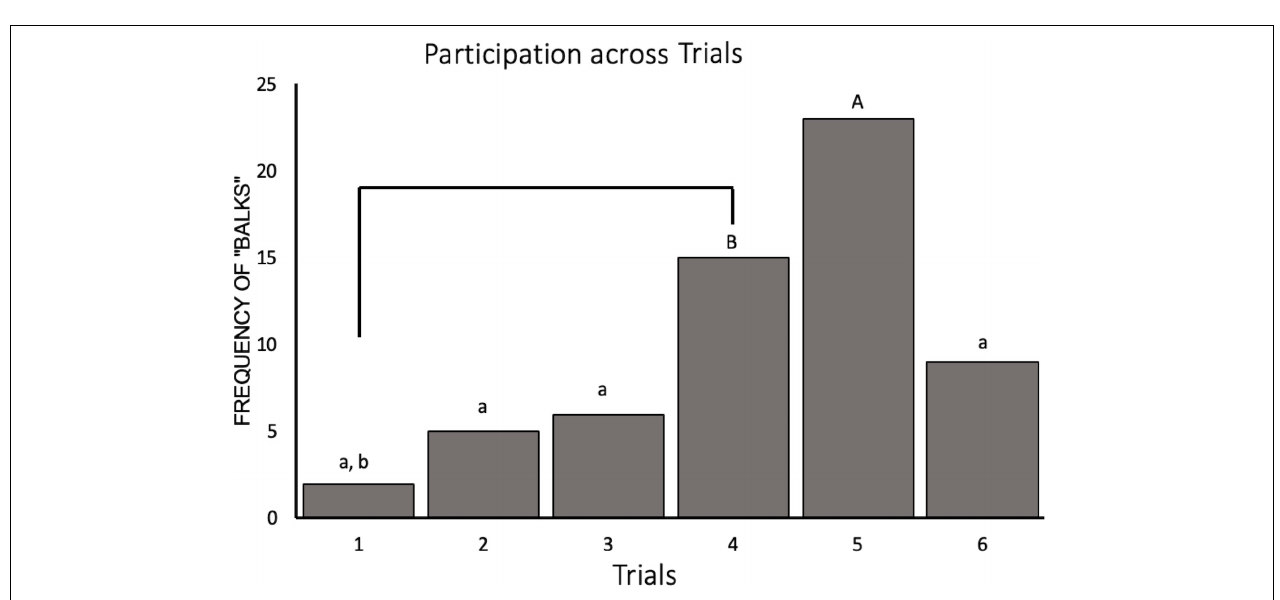
FIGURE 2 | A summary of each infant behavior ( N = 25) by condition. Locomotion represents the number of times an infant crossed a gridline, vocalizations are a count of all infant vocalizations during the trial, and grate touch plus grate zone behaviors are measured in seconds (total time per trial was 300 s). ∗ p < 0.05, ∗∗ p < 0.01, ∗∗∗ p < 0.001.